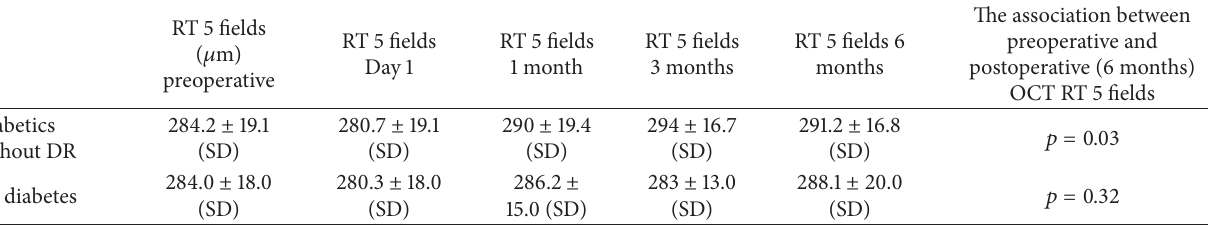
Table 4: Mean retinal thickness of the macular 5 fields (RT 5 fields) at optical coherence tomography in 𝜇 m preoperatively and at all follow- ups.